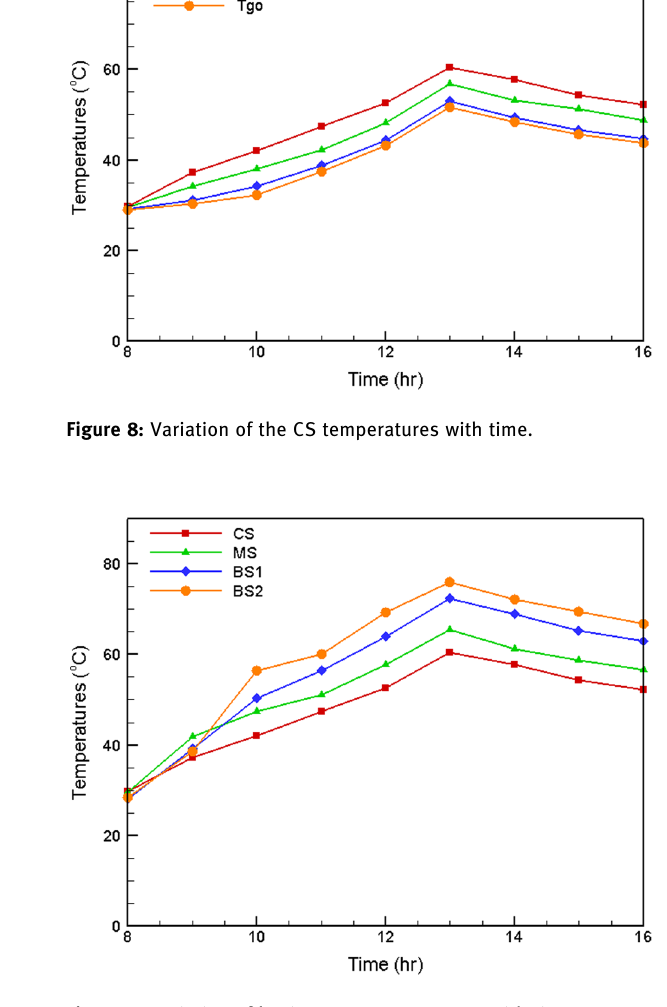
Figure 9: Variation of basin water temperatures with